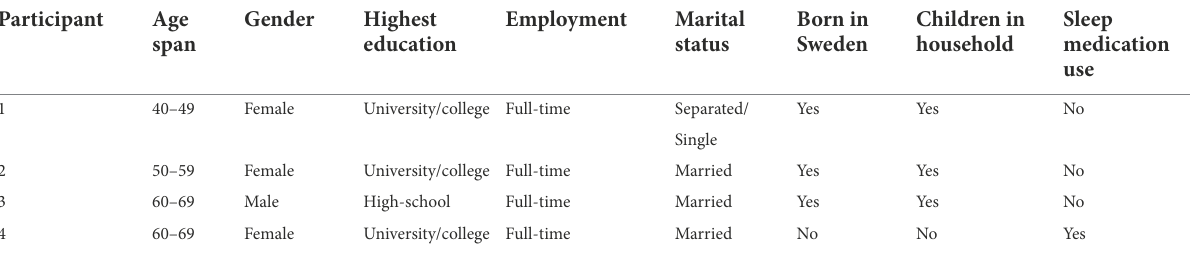
TABLE 1 Demographic